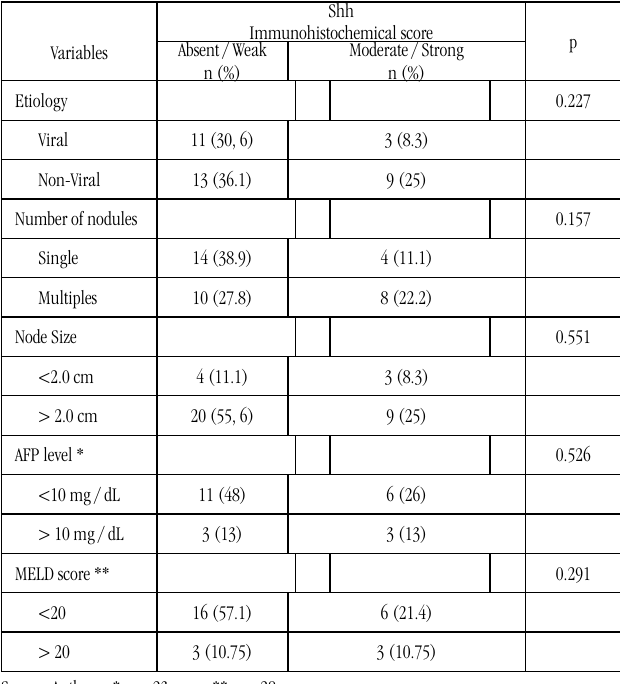
TABLE 4 - Correlation between the Shh protein immunohistochemical score in the tumor parenchyma and Etiology, Number of nodules, Size of the nodules, Levels of alpha-fetus-protein (AFP), and MELD score in HCC from liver transplant performed at HC-UFMG in the period between 2003 and 2015 Shh Immunohistochemical score p Absent / Weak Variables n